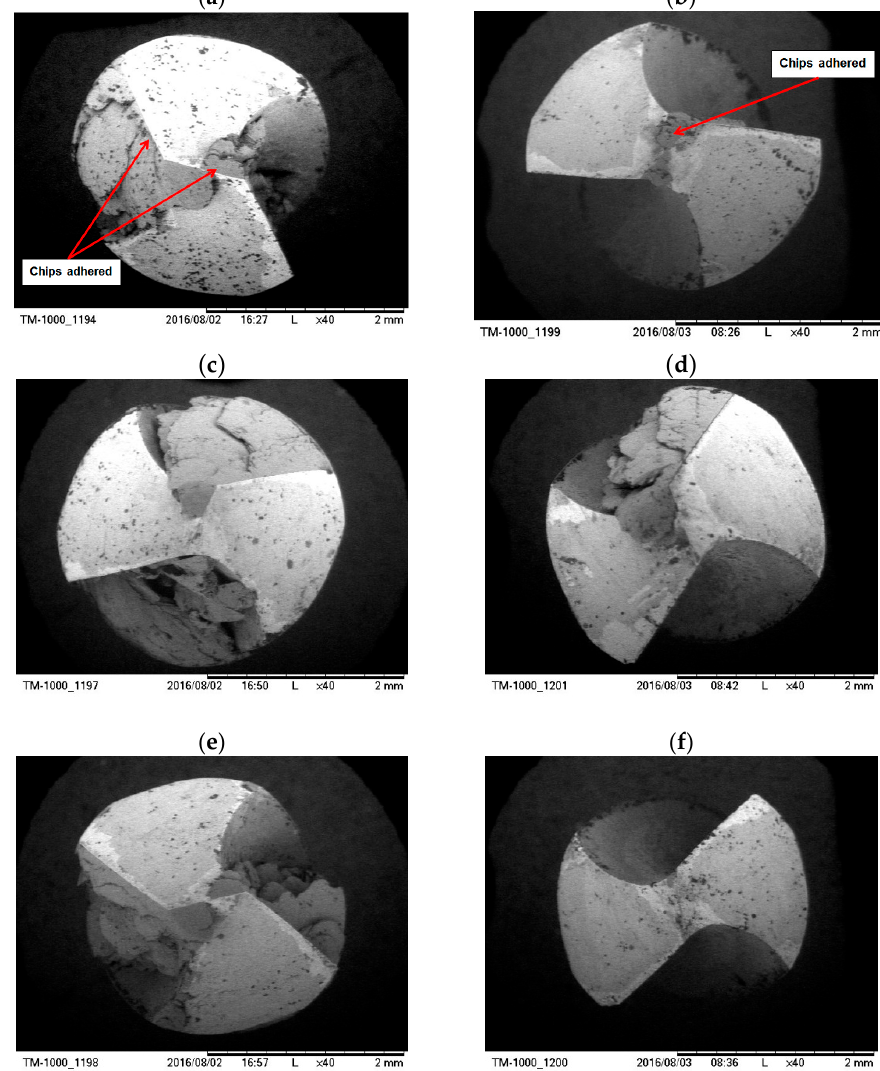
Figure 6. Photographs taken at cutter edges after producing 5 holes in CD ( a , c , e ) and UAD ( b , d , f ); an axial force of 6 kgf ( a , b ), 9 kgf ( c , d ), or 12 kgf ( e , f ) was applied.